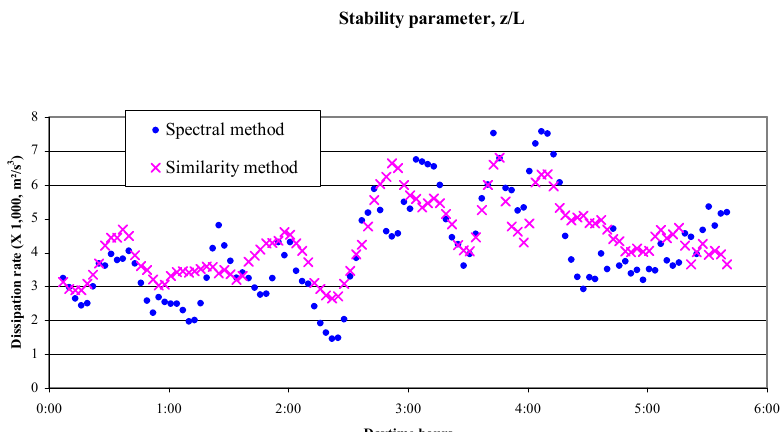
Fig. 11. Chart of the normalized TKE dissipation rate by night for the five lev- els on plot CT (25 July 1997), i.e. level 1 (cross), level 2 (circle), level 3 (tri- angle), level 4 (X), level 5 (star), solid and dash lines verifying equations y = γ(z/L) .